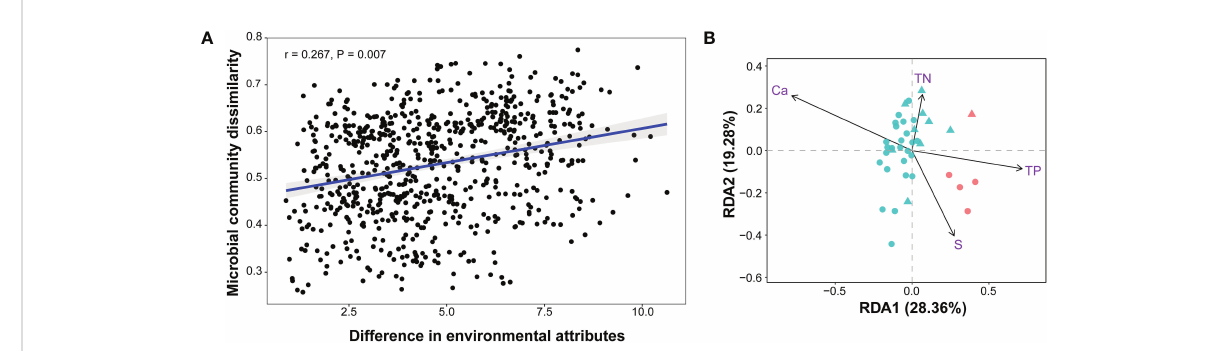
FIGURE 5 Correlations between the prokaryotic communities and environmental attributes (12 physicochemical factors and depth) of all 39 samples. Bray- Curtis distances of prokaryotic communities and Euclidean distances of environmental attributes among samples were calculated. (A) Spearman correlation. (B) Redundancy analysis (RDA). The arrows indicate signi fi cant factors; the red and blue colors indicate HFS and NHFS samples, respectively; the dots and triangles indicate CR and SWIR samples,